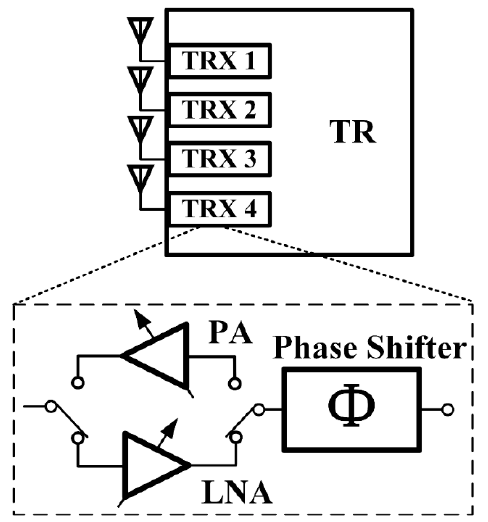
Figure 1. Block diagram of the phased-array transceiver.